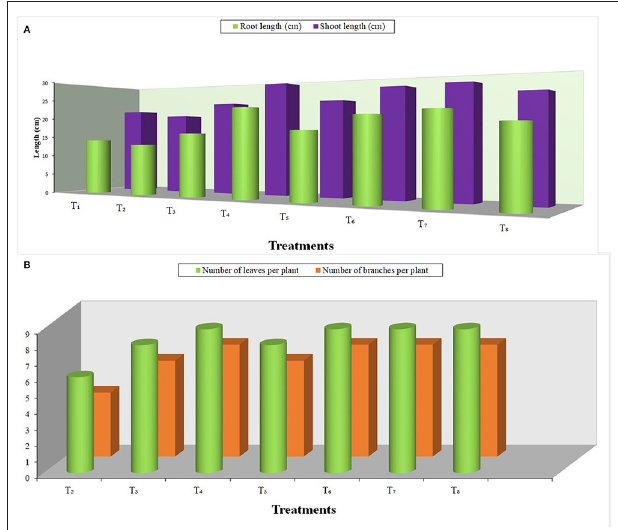
FIGURE 4 | Effect of phyllosphere bacteria on cotton growth parameters under drought conditions. (A) Plant height (B) number and leaves, and number of branches per